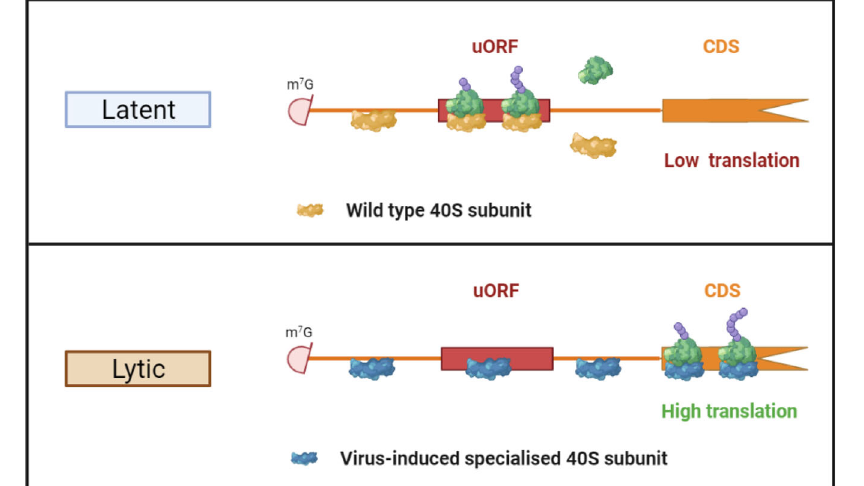
Fig. 6 | KSHV co-opts ribosome biogenesis during lytic replication to produce virus-speci fi c specialised ribosomes. Enhanced association of BUD23, most likely driven by ORF11, with pre-40S ribosome complexes, during KSHV lytic replication drives the production of virus-speci fi c specialised ribosomes. These ribosomes